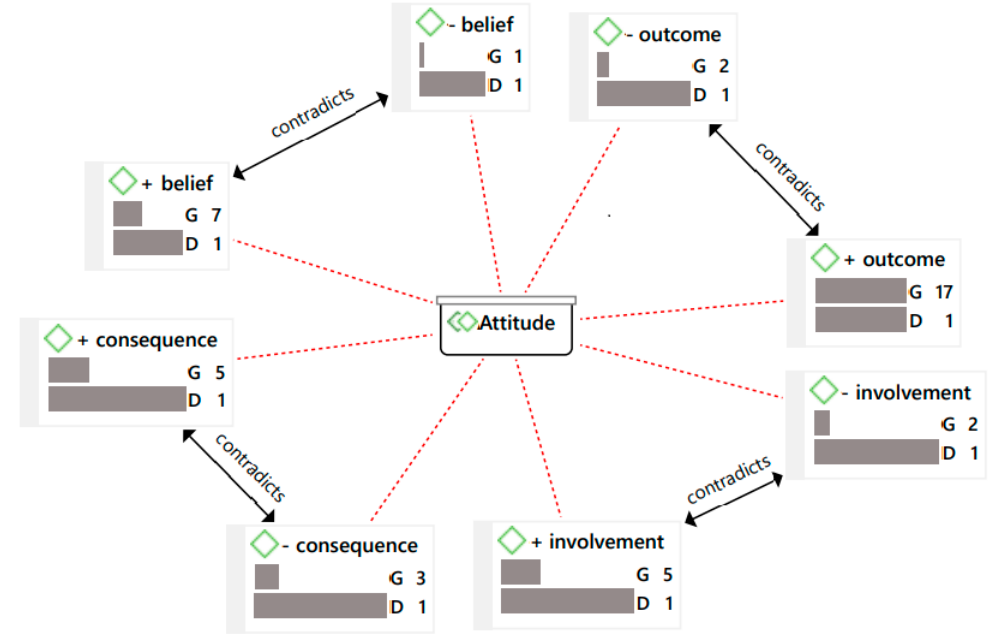
Figure 2. Attitude determinants in the participants’ view (source: original).